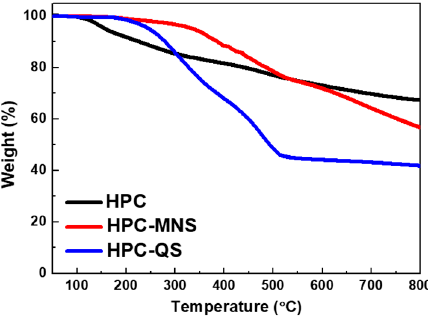
Figure 2. Molecular weight distribution of HPC, HPC-MNS and HPC-QS.